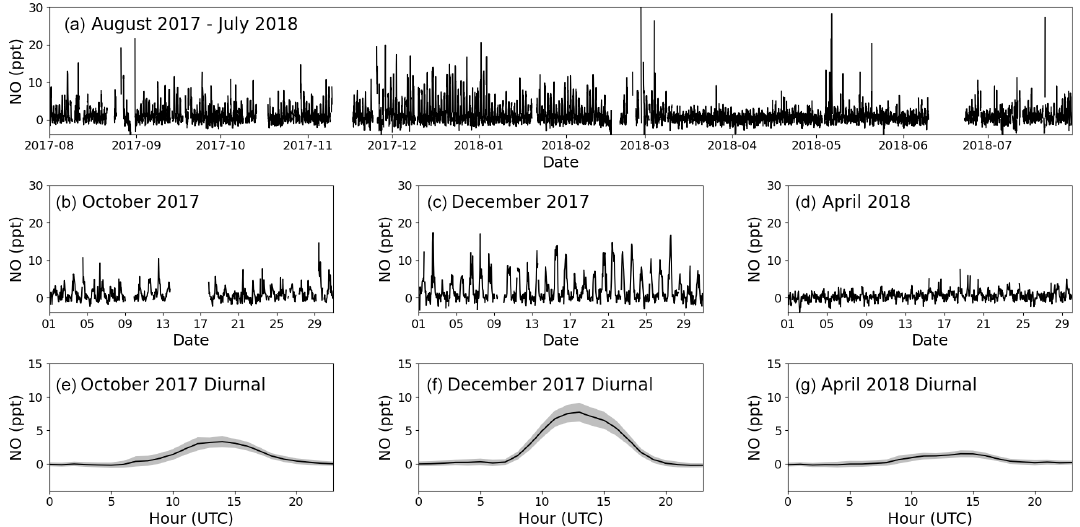
Figure 5. Panel (a) shows the time series for filtered O 3 -corrected NO from 1 August 2017 to 31 July 2018. Panels (b) , (c) , and (d) zoom in on October 2017, December 2017, and April 2018, respectively. Panels (e) , (f) , and (g) show the average diurnal of NO for October 2017, December 2017, and April 2018, respectively, with the coloured areas being ± 2 standard errors. If there are fewer than 15 measurements available for the hour, it is not included in the